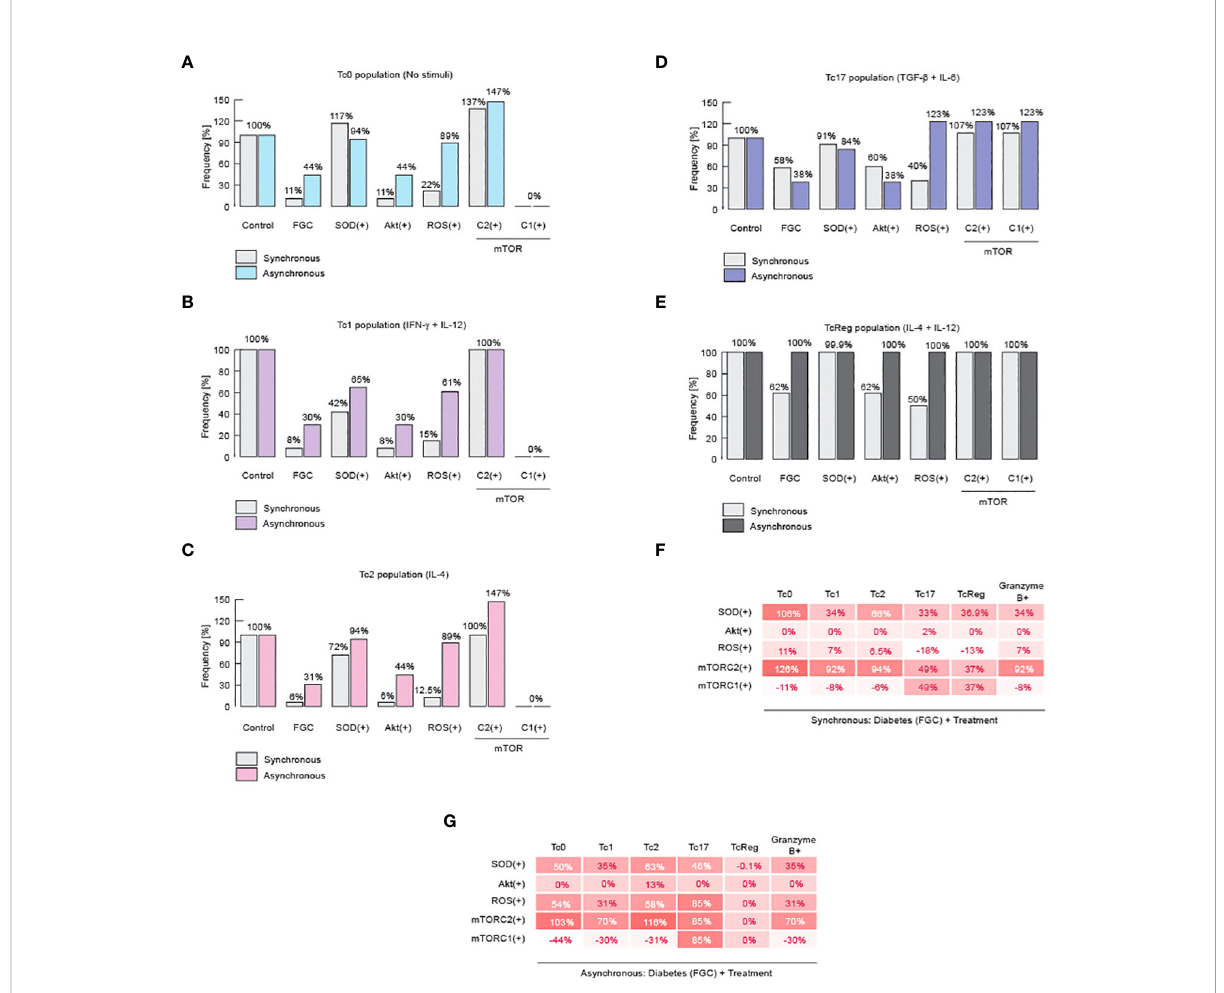
FIGURE 5 mTORC2 and inhibition of ROS might normalize metabolic alterations on CD8+ T cells. Results of knock-in simulation analysis. (A) Effects of knock-ins over Tc0 phenotype. (B) Effects of knock-ins over Tc1 phenotype. (C) Effects of knock-ins over Tc2 phenotype. (D) Effects of knock- ins over Tc17 phenotype. (E) Effects of knock-ins over TcReg phenotype. (F) Summary of total changes due to knock-ins according to the synchronous model. (G) Summary of total changes due to knock-ins according to the asynchronous model. FGC: diabetic context given by dyslipidemia, hyperglycemia, and high levels of